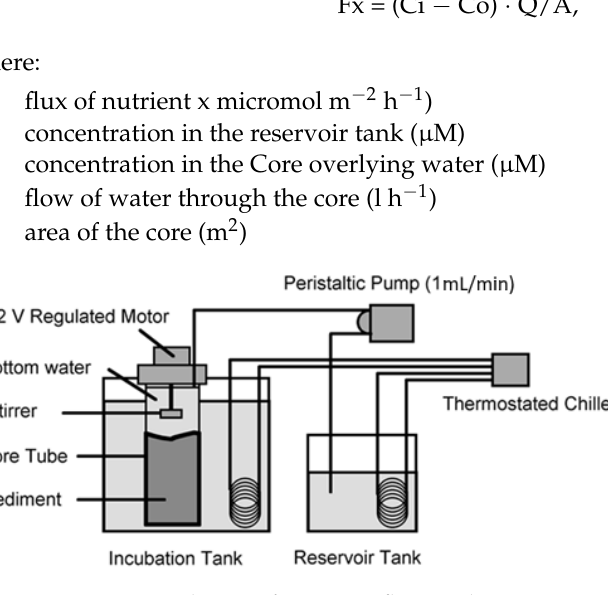
Figure 2. Experimental set-up for oxygen flux incubation.